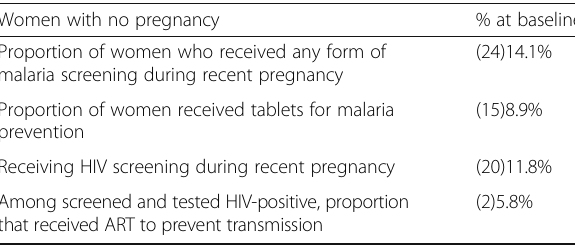
Table 1 Results of women who received infectious disease control services received from fixed health centres Women with no pregnancy % at baseline Proportion of women who received any form of malaria screening during recent